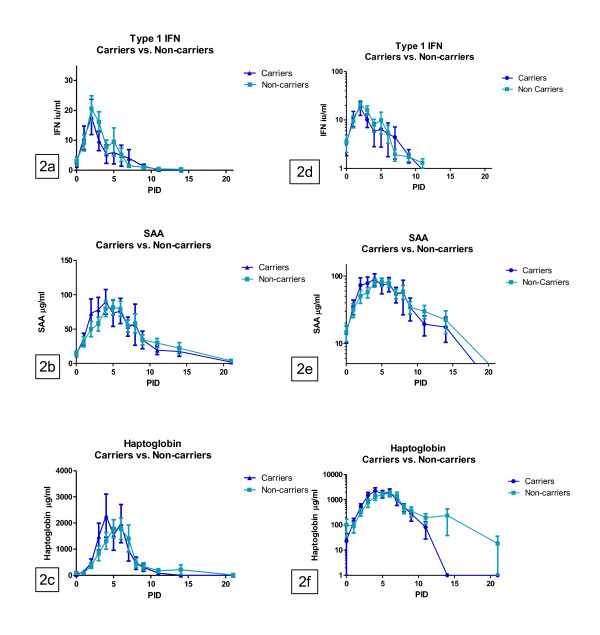
Comparison of acute phase protein and IFN measurements in carrier and non-carrier cattle on linear (a-c) and logarithmic scale (d-f). a+d) Bioactivity of type 1 IFN in serum (iu/mL). b+e) Serum amyloid A in serum (μg/mL). c+f) Haptoglobin in serum (μg/mL).